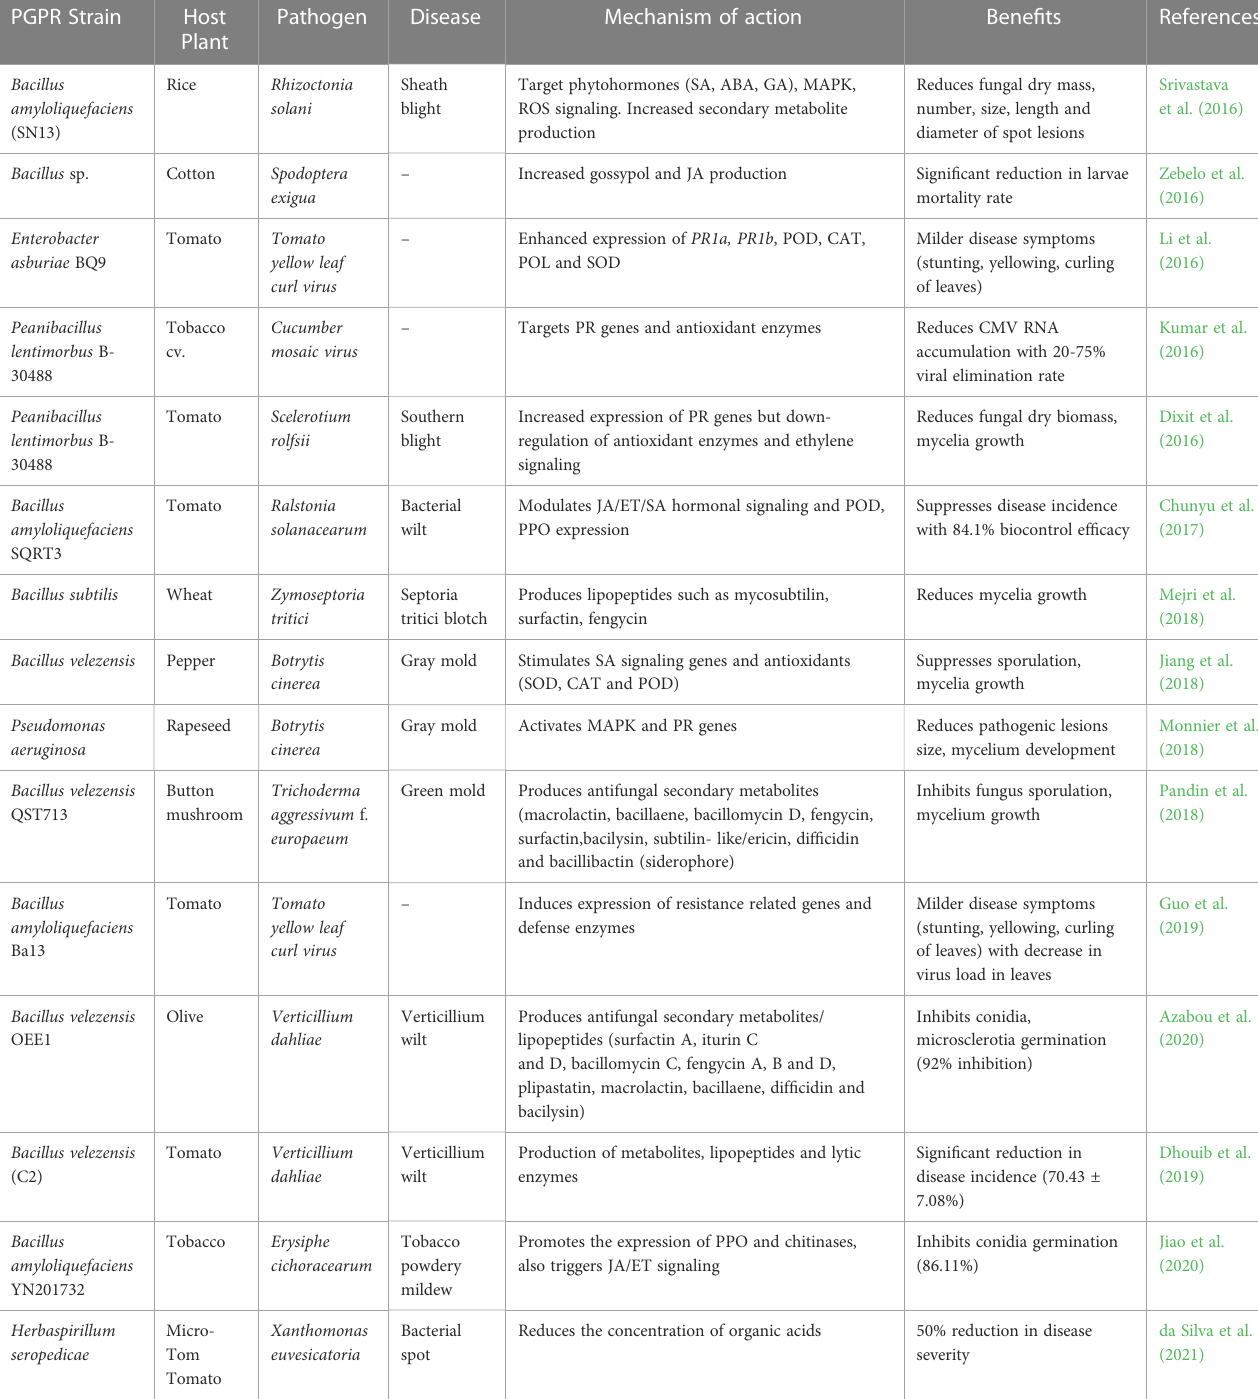
TABLE 2 PGPRs along with their mode of action in combating biotic